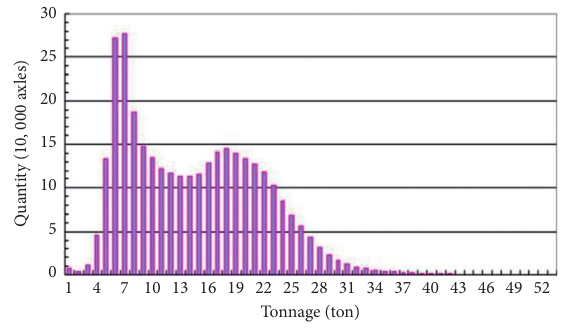
Figure 9: Double-axle load spectrum.